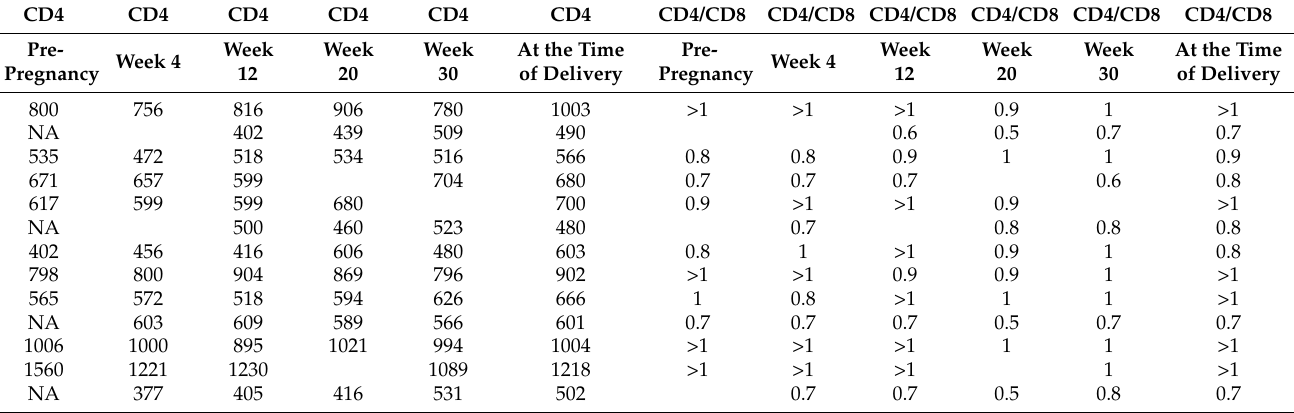
Table 1. CD4 cells counts and CD4/CD8+ ratio